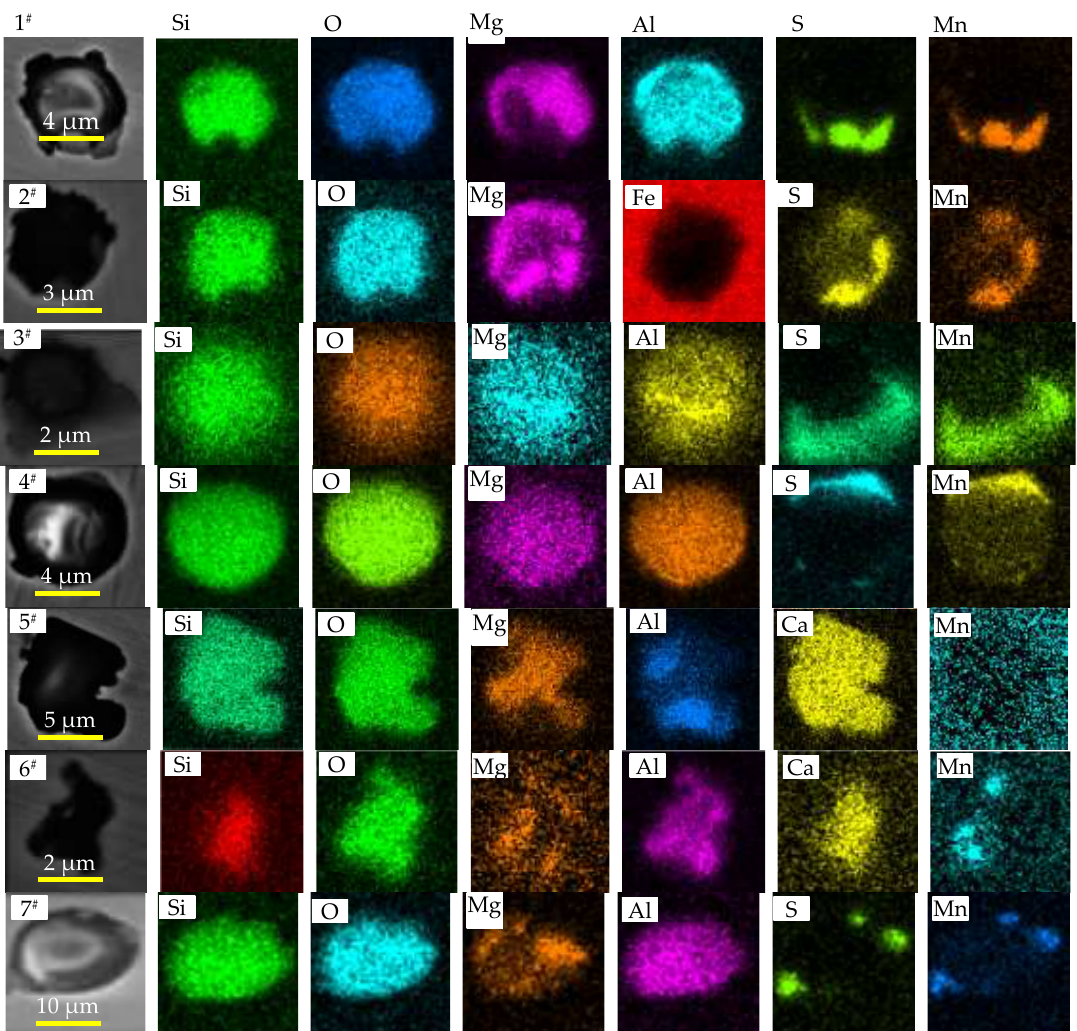
Figure 5. Elemental mapping of inclusions in steel samples.